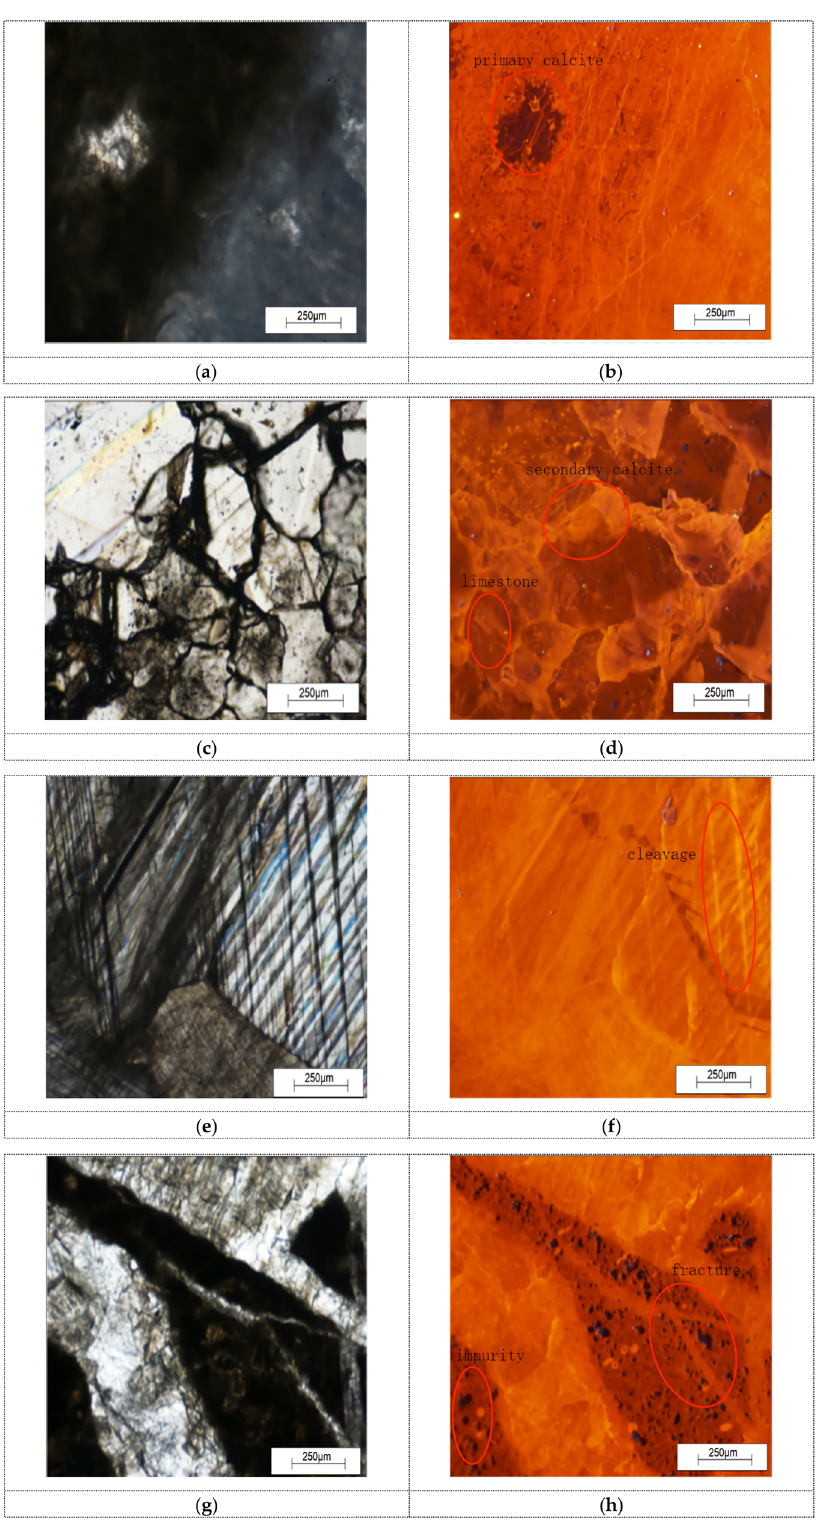
Figure 2: Cathodoluminescence characteristics of the D 3 x - C 1 d reservoirs in the central Hunan